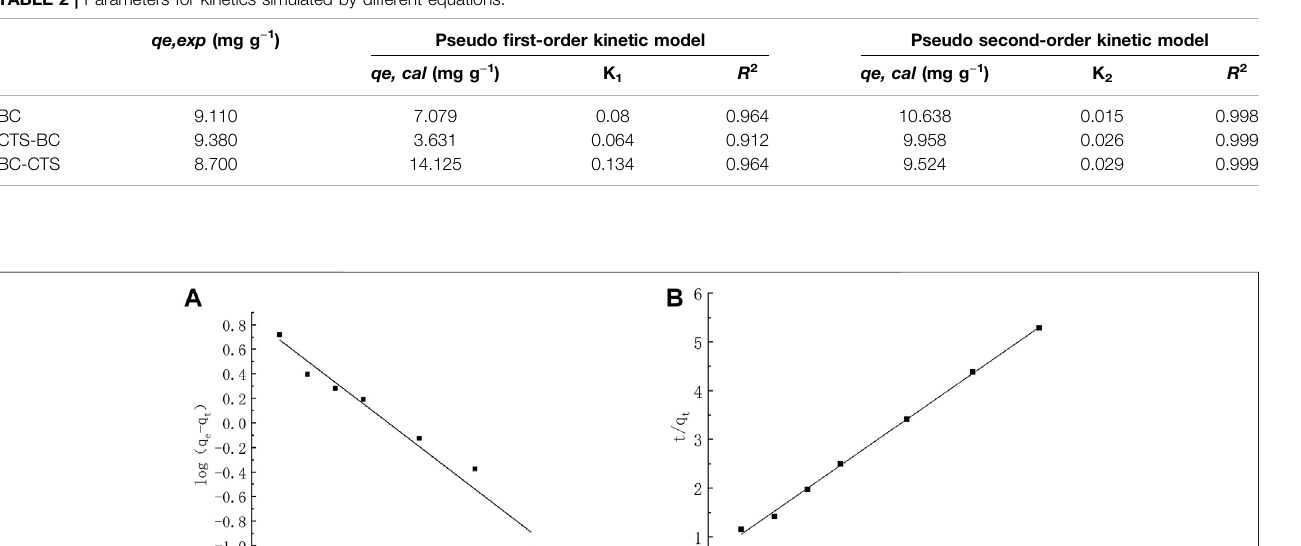
TABLE 2 | Parameters for kinetics simulated by different equations.